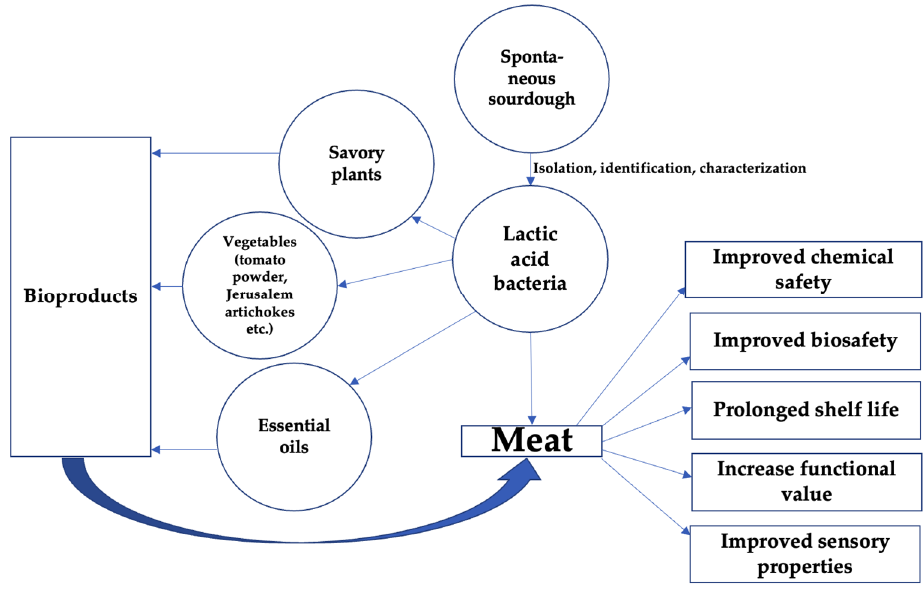
Figure 3. Possible uses of pure lactic acid bacteria starters and their combinations for the preparation of safer, higher-value, and more acceptable meat and meat products.